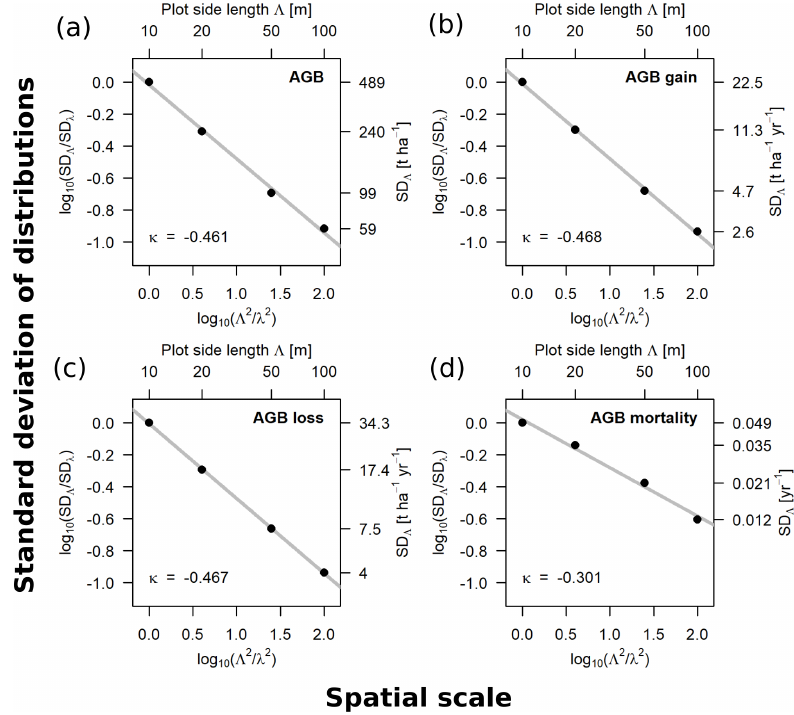
Figure 3. Scaling relationships for aboveground biomass (AGB) (a) , gain (b) , loss (c) and mortality (d) , derived from the standard devi- ations (SD) of the empirical distributions. Fitted slopes represent the scaling exponents ( κ in Eqs. 1–3). Plotted are the log 10 -transformed ratios of the SDs over the log 10 -transformed ratios of plot areas, with 10m being the reference scale ( λ ). The top axis shows the plot side lengths ( (cid:51) ), and the right axis shows the values of the SD for each scale,